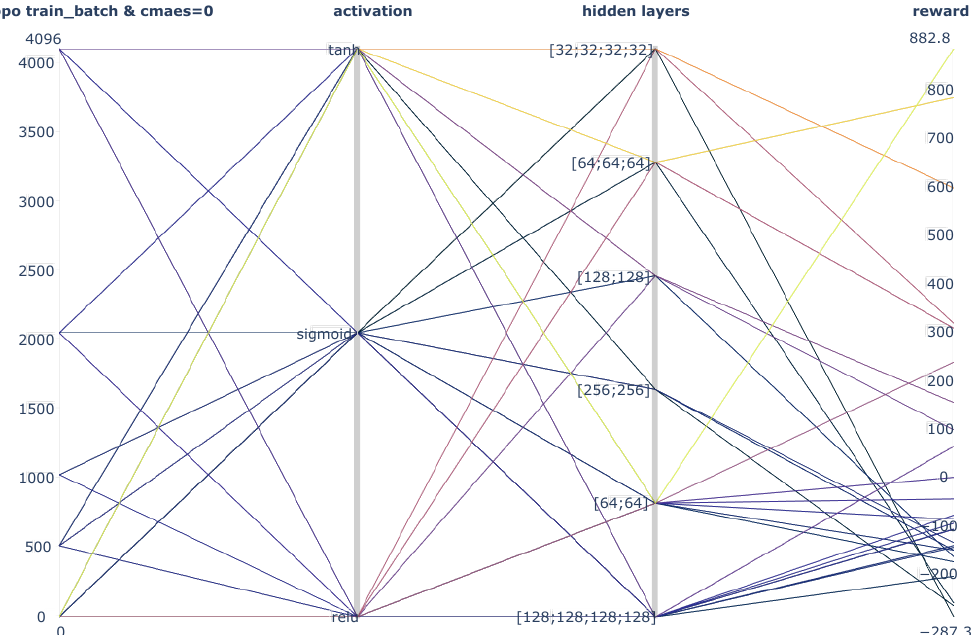
Figure 4. Parallel coordinate plot showing the average reward obtained in various training sessions as a function of the training algorithm, network architecture, training batch size (Proximal Policy Optimization (PPO)) and activation function. First, several PPO training sessions are presented, with the following main hyperparameters: γ = 0.995, λ = 0.95, lr = 3 × 10 − 4 (obtained with a stochastic hyperparameter search). Secondly, training results of the covariance matrix adaptation evolution strategy (CMA-ES) algorithm are shown, with the following parameters ( pop size = 8, σ init = 0.1). It should be noted that the first axis on the left of the graph represents both the use of PPO algorithm and its training batch size (value greater than 0) and the use of the CMA-ES algorithm (value equal to 0). We found that the PPO algorithm often misses promising policies, preventing us from obtaining the desired behavior and thus having a lower average reward. The result of this hyperparameter optimization phase determines the number of neurons, layer structure and activation function used for our final